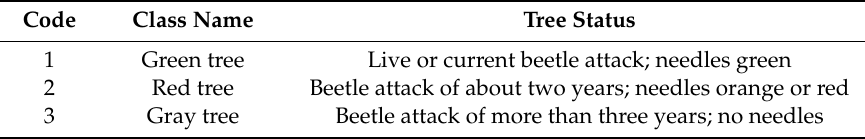
Table 1. Three stages of individual trees according to the sample plot survey.